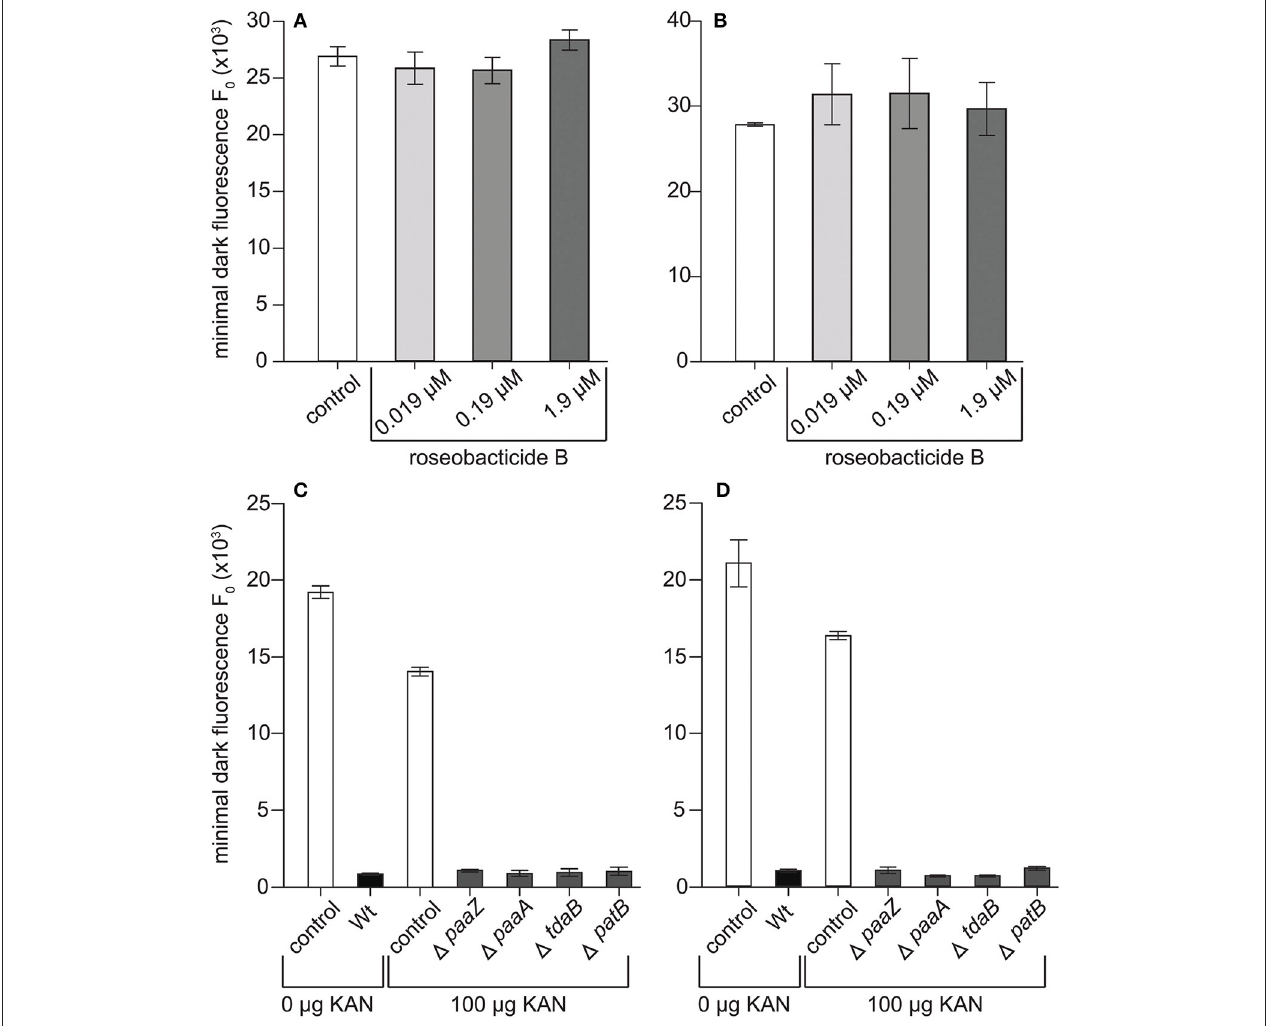
FIGURE 4 | P. inhibens has a roseobacticide-independent mechanism for killing diploid calcifying C cells (CCMP3266) and haploid S cells (CCMP3268). Minimal algal fluorescence of the population (F 0 ) is shown for (A) senescent CCMP3266 cells and (B) senescent CCMP3268 cells cultured with roseobacticide B. Both cell types were incubated for 24h with methanol (white bar) and with 0.019 µ M (lightest gray), 0.19 µ M (gray), and 1.9 µ M (darkest gray) roseobacticide B, dissolved in methanol. The final concentration of methanol solvent added to control and experimental cultures was 2% of the final volume. P. inhibens transposon mutants deficient in roseobacticide synthesis were co-cultured with (C) CCMP3266 and (D) CCMP3268. Minimal algal fluorescence of the population (F 0 ) was measured on day 10. Triplicate wells that represent independent experiments were sacrificially sampled; error bars represent ± 1 standard